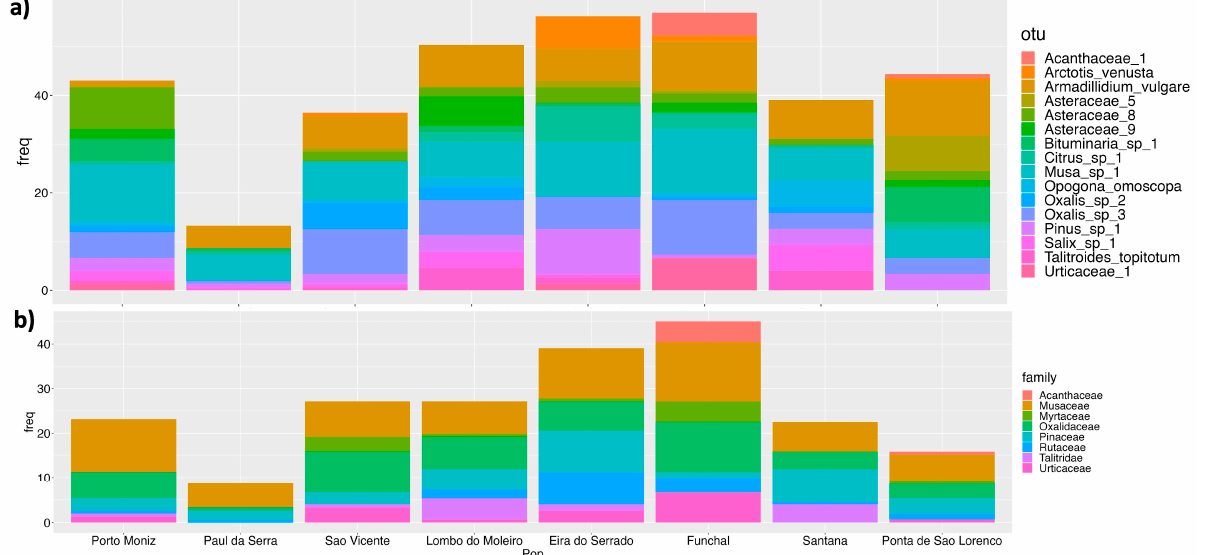
Figure 6. Stacked histogram representing the frequency of occurrence of the OTU ( a ) and family ( b ) diet items ingested by T. dugesii in significant proportions, according to the univariate tests. See Table S4 for details.